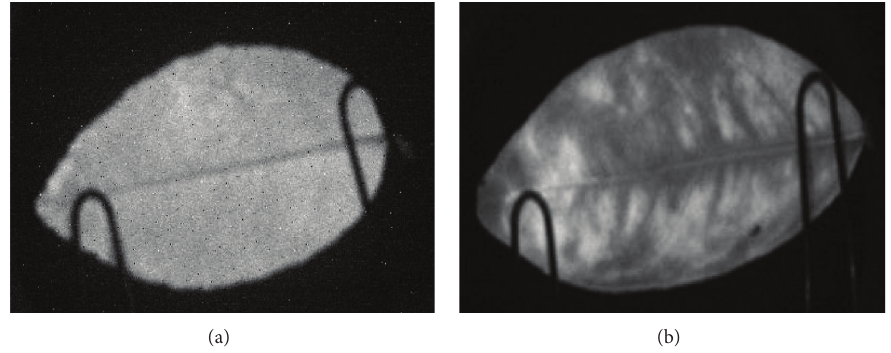
F 2: Fluorescence intensity at 690nm of healthy (a) and HLB-infected leaves (b).